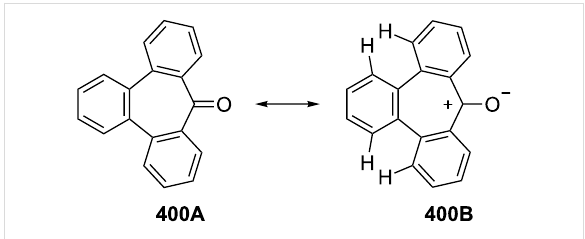
Figure 20: Resonance structures of tribenzotropone ( 400